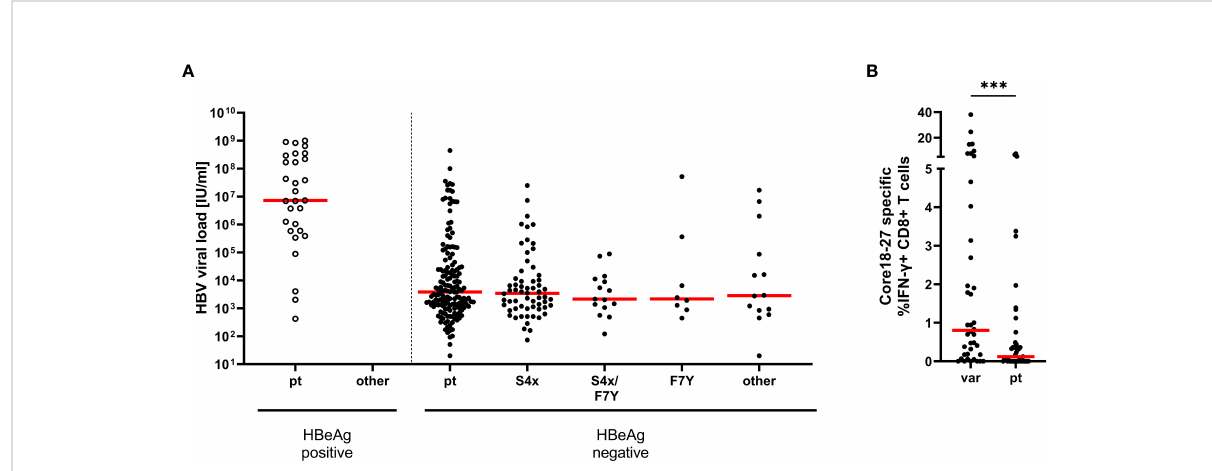
FIGURE 3 Association between HBV-DNA and variants in the epitope core 18-27 . (A) The HBV-DNA concentration is shown for 280 treatment-naive patients (genotype A and D) according to the absence and presence of substitutions in position 4 and 7 of the epitope. Patients were grouped according their epitope sequence and their serological HBeAg status as indicated. pt = prototype, S4X = any variant at position 4. (B) core 18-27 - speci fi c CD8 + T cells responses from patient samples shown in Figure 1A, in HBeAg negative patients according to their epitope sequence (Supplemental Table 1); var = any variation in the core 18-27 epitope; pt = prototype. Statistical signi fi cance was calculated with the Mann-Whitney-test (p = 0.0001). *** =